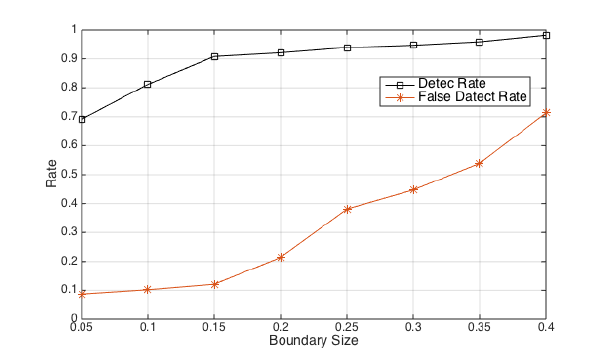
Figure 14: Detection rate and false detection rate varies with the boundaries size (X-axis only shows the lower boundary, so upper boundary should be 100% − LowerBoundary , the boundary range should be UpperBoundary − LowerBoundary )